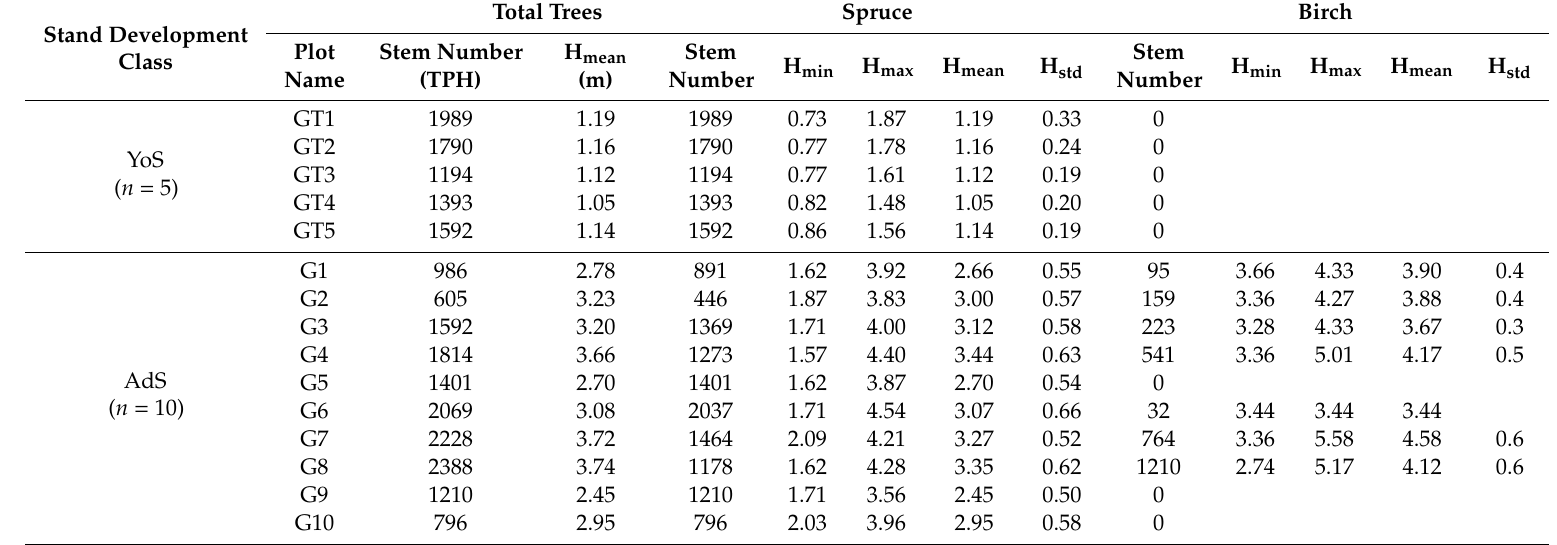
Table 1. Tree height variation in sample plots. YoS: young seedling stands, AdS: advanced seedling stands, H min , H max , H mean , and H std : minimum, maximum, mean and standard deviation of field-measured heights (TPH: Trees per hectare, Height unit: meter). Total Trees Spruce Stand Development